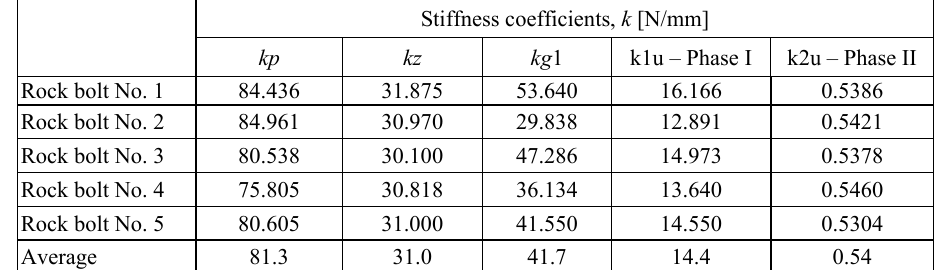
Table 3. The stiffness of the components of the rock bolt support and the rock bolt with increased deformability as a system composed of those elements